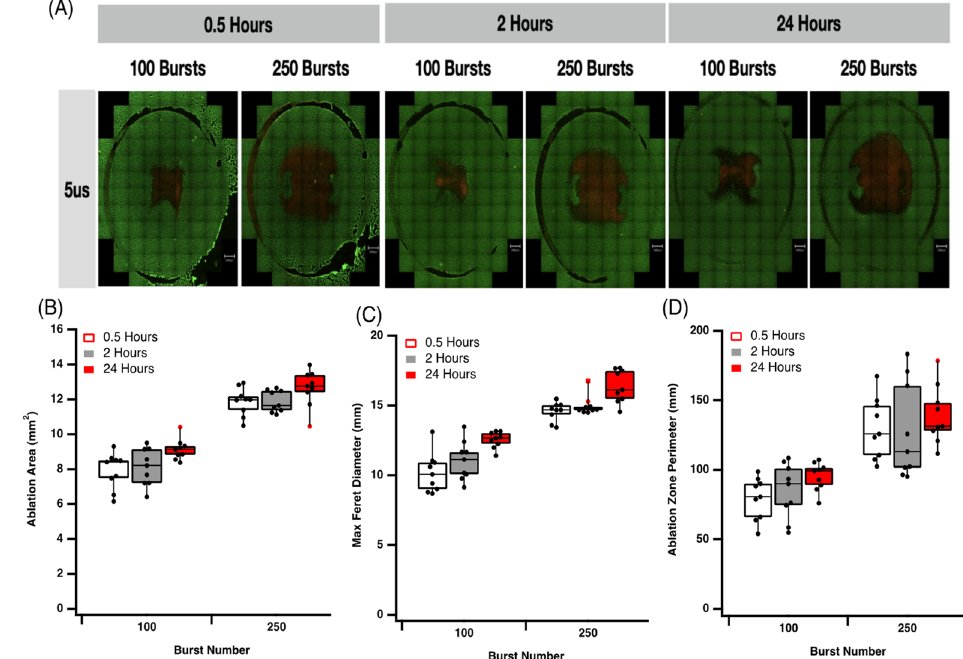
Figure 5. Effect of 5 µ s pulses and burst number on cardiomyocyte lesion size. ( A ) Effect of 5 µ s pulse duration on cell survival. ( B ) Effect of burst number over time on ablation area. ( C ) Effect of burst number over time on max Feret diameter. ( D ) Effect of burst number over time on ablation zone perimeter. Data are representative of at least 3 independent experiments and plotted as max, min and median.